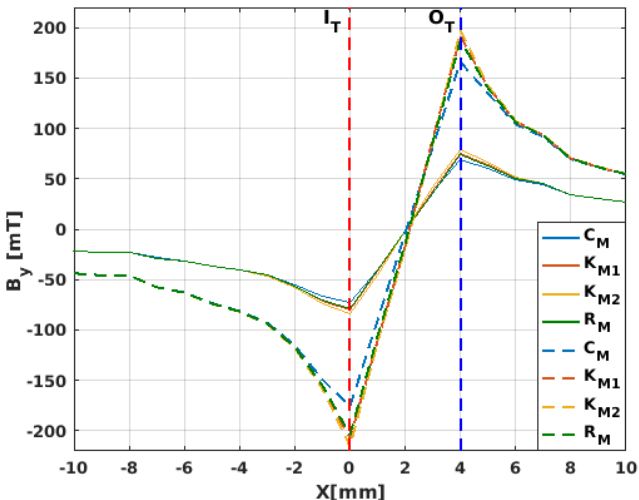
Figure 3. Magnetic field profile over the middle axisymmetric line ( x -axis) of the ∼ 4-mm coil section (20 turns) displayed in Figure 1 in the direction parallel to the wider surface of the wound 2G-HTS tape, B y , measured within and near the coil section for applied currents of amplitude I a = I c 0 (dashed curves) and I a = 0.5 I c 0 (solid curves), at the peak condition ω t = 5 π /2. The vertical dashed lines at x = 0 mm and x = ∼ 4 mm respectively refer to the innermost ( I T ) and outermost ( O T ) turns of the HTS